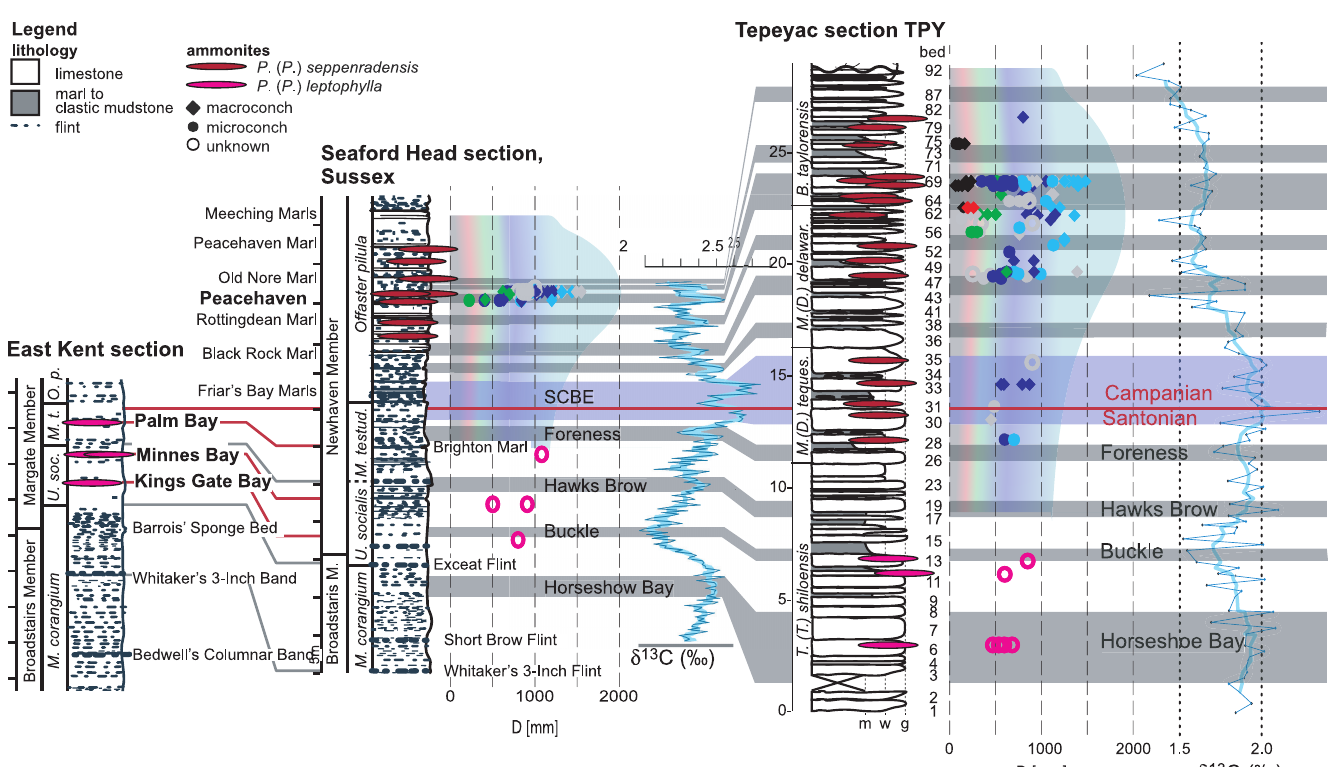
Fig 3. Stratigraphic distribution of Parapuzosia and their diameters from the English Chalk of east Kent and Sussex, U.K., and from Tepeyac, northern Coahuila, Mexico. Chalk sections are [redrawn from 14, 15]. Colors refer to growth stages in P . ( P .) seppenradensis (see also Fig 5). δ 13 C distribution in the Chalk from [4]. The East Kent and Sussex sections are correlated by bio- and lithostratigraphy, correlation to Mexico by δ 13 C chemostratigraphy. Abreviations for biostratigraphy: M . corangium : Micraster corangium M . ( D .) delaw .: Menabites ( Delawarella ) delawarense , M . ( D .) tequesqu .: Menabites ( Delawarella ) tequesquitense , M . t . and M . testud .: Marsupites testudinarius , O . p .: Offaster pilula , U . soc .: Uintacrinus socialis